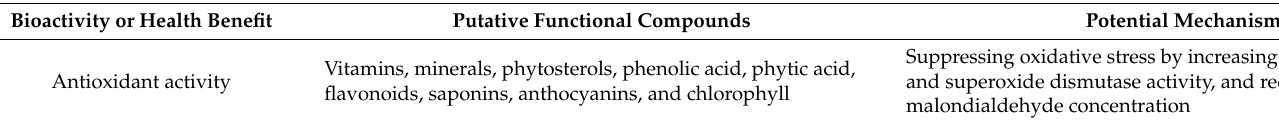
Table 2. Bioactivity and health benefits of Z. latifolia seeds (Chinese wild